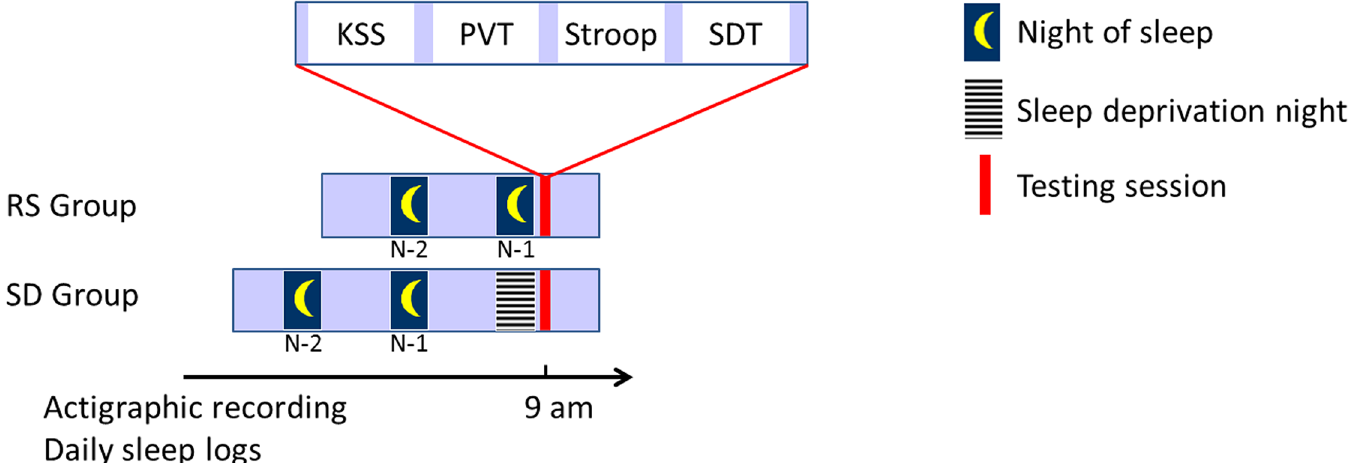
Fig 1. Experimental design. Regular Sleep group (RS), Sleep Deprived group (SD), Karolinska Sleepiness Scale (KSS), Psychomotor Vigilance Task (PVT), Stroop Task (Stroop), Sarcasm Detection Task (SDT), the night (N-1) and two nights (N-2) preceding the experimental session (RS: task administration; SD: sleep deprivation night and task